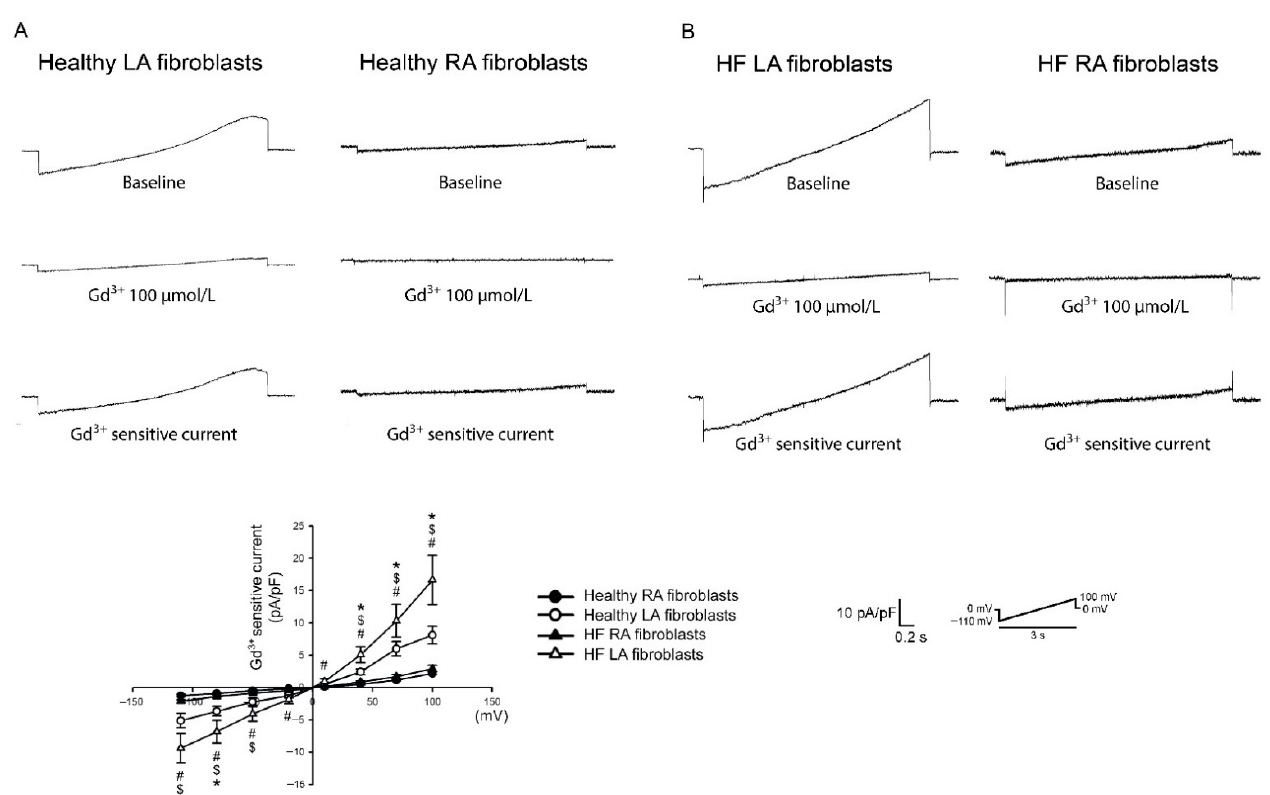
Figure 2. Membrane gadolinium (Gd 3+ )-sensitive Ca 2+ currents of the left atrium (LA) and right atrium (RA) fibroblasts in healthy and heart failure with reduced ejection fraction (HF) rats. ( A ). Left and right panels, respectively, reveal tracings of the Gd 3+ (100 µ mol/L)-sensitive nonselective cation current of LA and RA fibroblasts isolated from healthy rats. Healthy LA fibroblasts exhibited greater Gd 3+ -sensitive Ca 2+ currents compared with healthy RA fibroblasts. ( B ). Left and right panels, respectively, reveal tracings of the Gd 3+ (100 μ mol/L)-sensitive nonselective cation current of LA and RA fibroblasts isolated from HF rats. The statistical results revealed that healthy LA fibroblasts exhibited greater Gd 3+ -sensitive Ca 2+ currents compared with healthy RA fibroblasts. HF LA fibroblasts exhibited greater Gd 3+ -sensitive Ca 2+ currents compared with HF RA fibroblasts. LA fibroblasts from HF rats showed higher Gd 3+ -sensitive currents compared with LA fibroblasts from healthy rats. The insets in the current traces showed the various clamp protocols. * Healthy LA versus healthy RA fibroblasts; $ HF LA versus healthy LA fibroblasts; # HF LA versus HF RA fibroblasts (adapted from the published article by Chung et al. [59]).